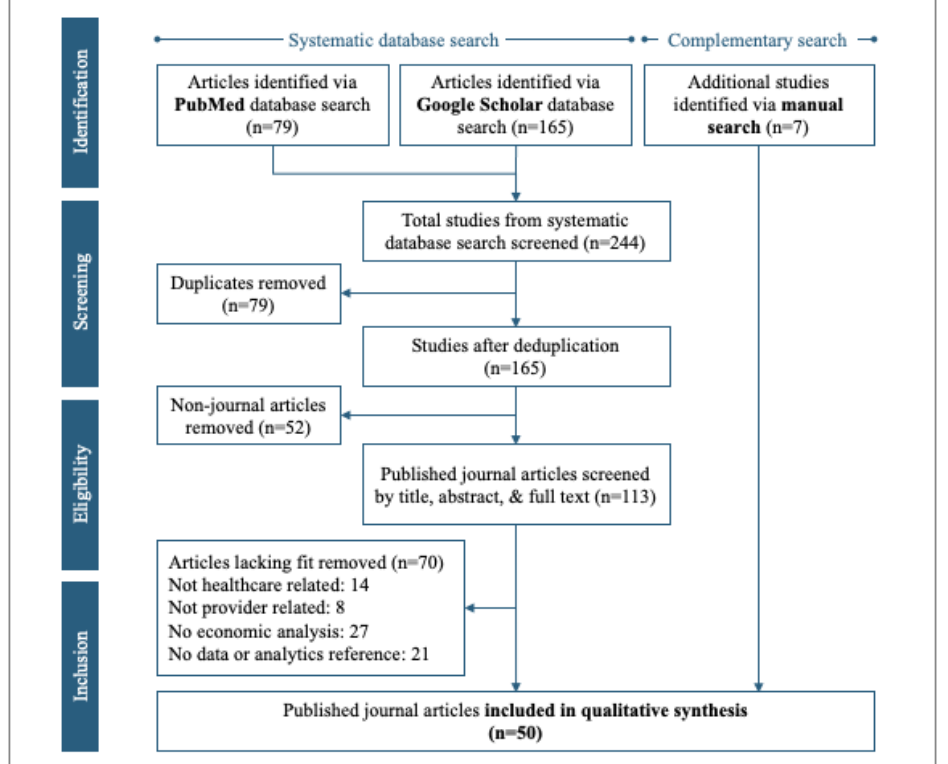
Figure 1. Literature search and study selection